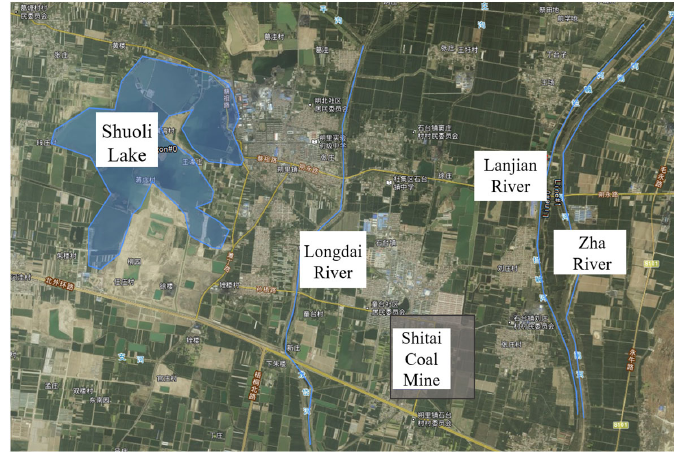
Figure 5. Schematic diagram of water sources near the Shitai